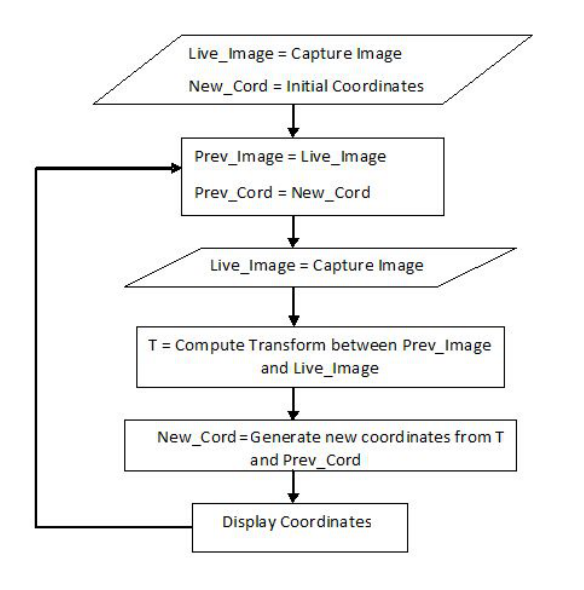
Figure 5: Flowchart of Visual Odometry. This figure shows the pro- cess of visual odometry for robot pose estimation.